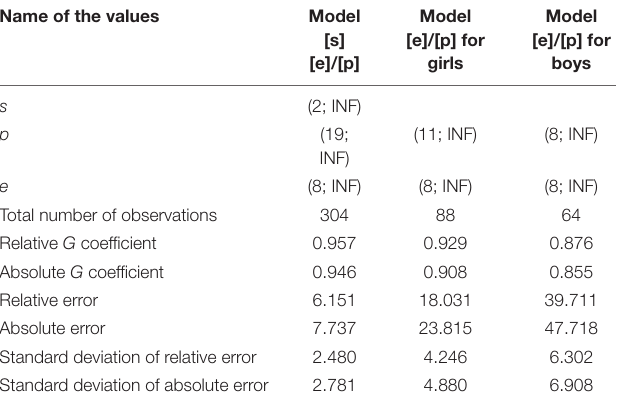
TABLE 1 | Models used in generalizability